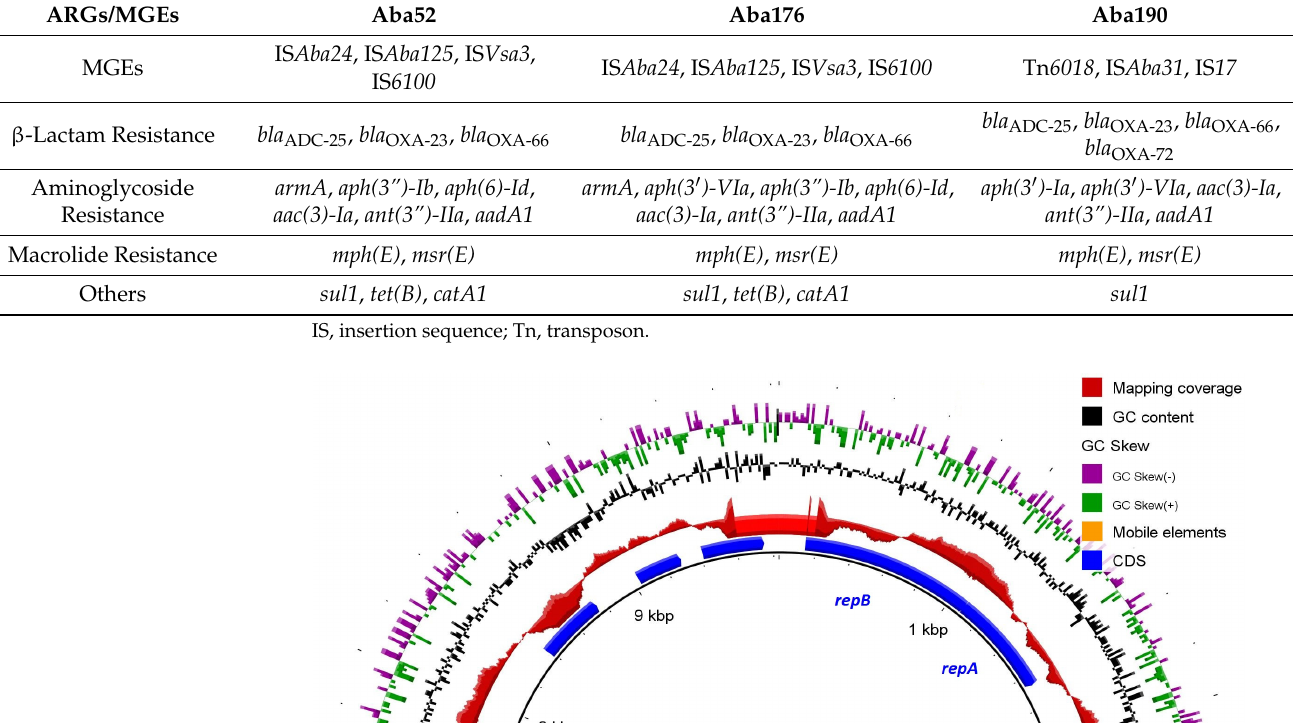
Table 4. Antimicrobial resistance genes (ARGs) and mobile genetic elements (MGEs) found in the A. baumannii isolates studied.